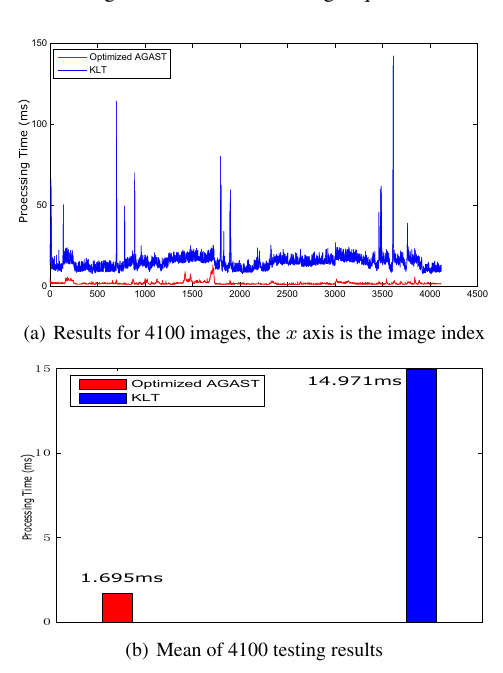
(a) x -axis errors (b) y -axis errors